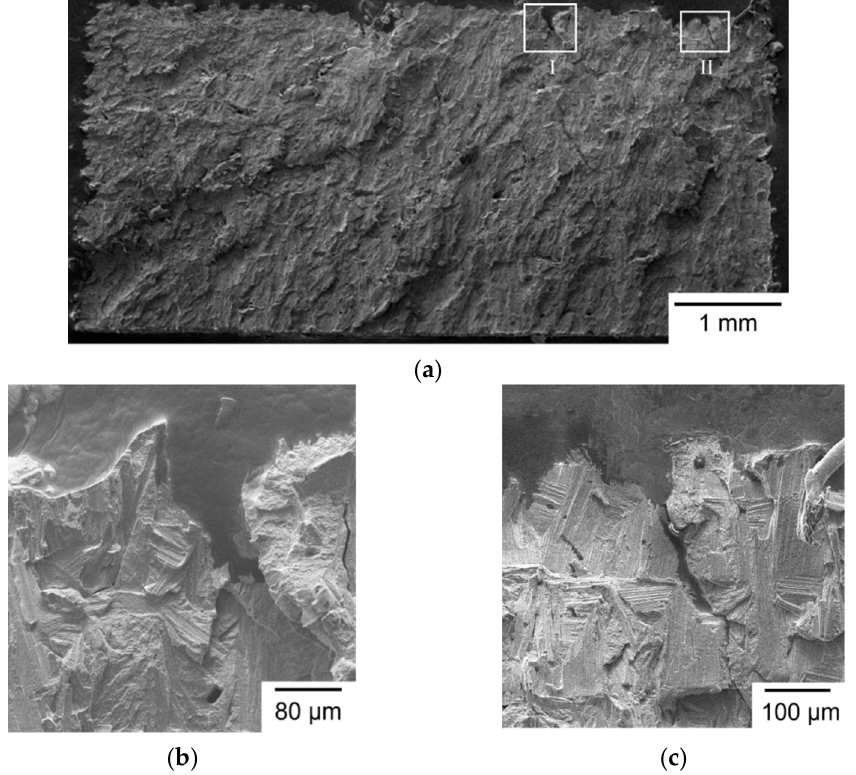
Figure 5. Fractography of a Group S2 specimen observed by SEM: ( a ) whole fracture surface; ( b ) fracture origin I; ( c ) fracture origin II.